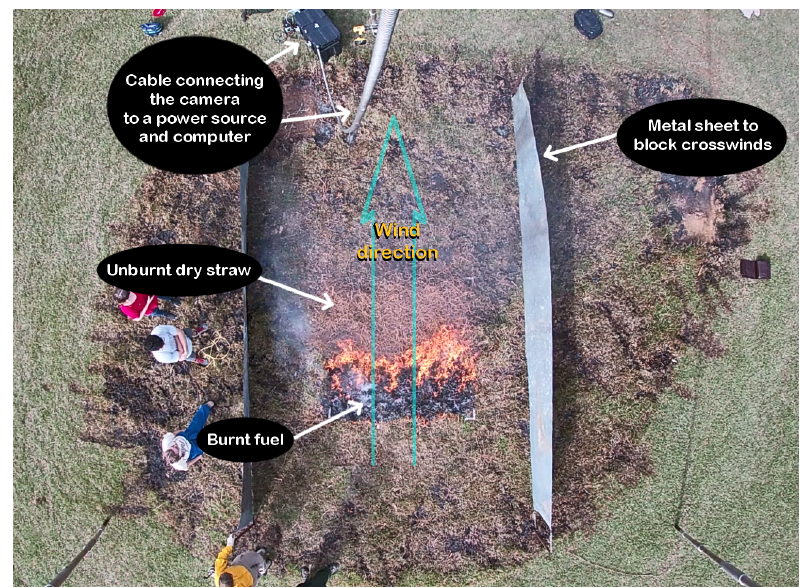
Figure 1. The experimental setup is a 2 m × 2 m plot of dry pine straw. The setup components are labeled. A fan is used to generate a nearly-uniform wind velocity, and metal sheets eliminate any crosswind